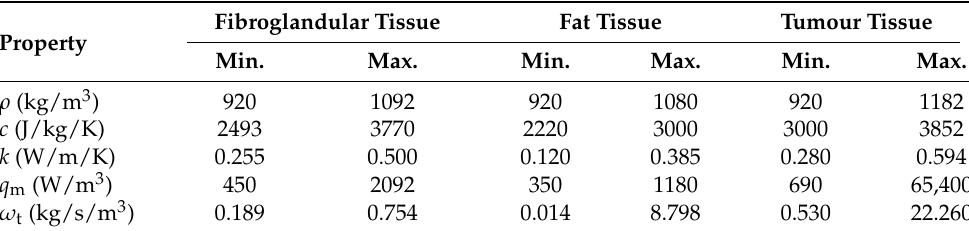
Table 7. The minimum and maximum values of the thermal and physiological properties of healthy and tumour breast tissue. Fat Tissue Tumour Tissue Property Min. Max. Min. Max. Min.